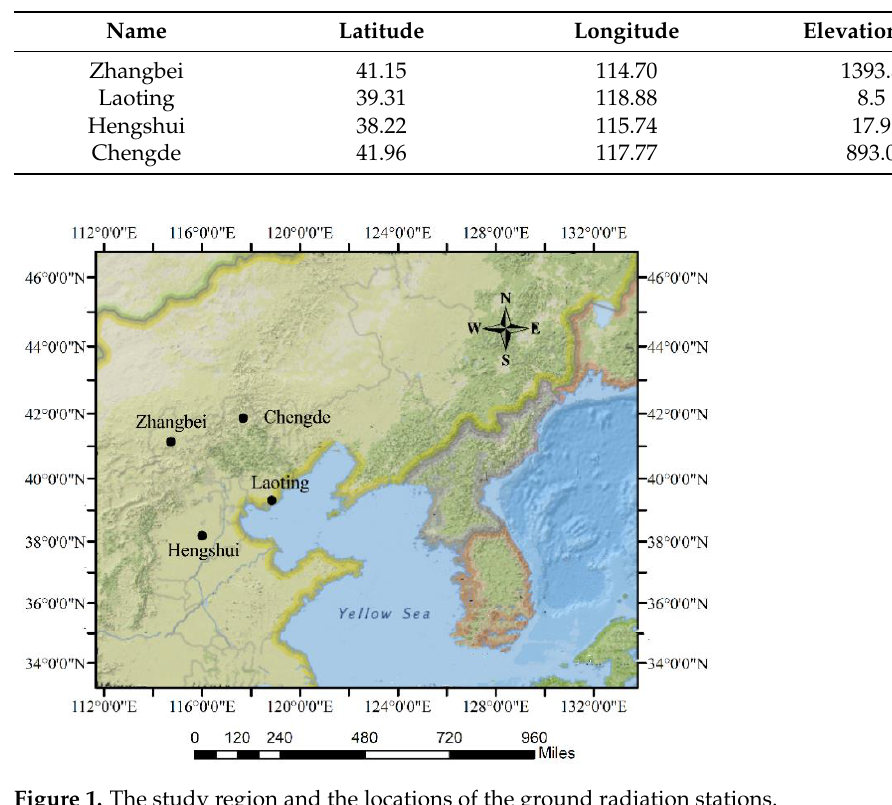
Table 2. Geographic information of the ground radiation stations.